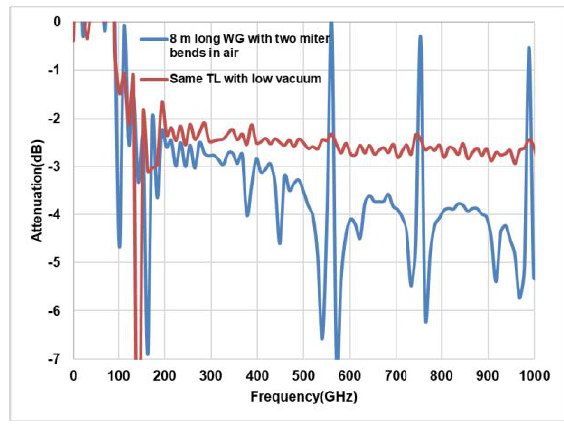
Fig. 9: Comparison of transmission attenuation in air and low